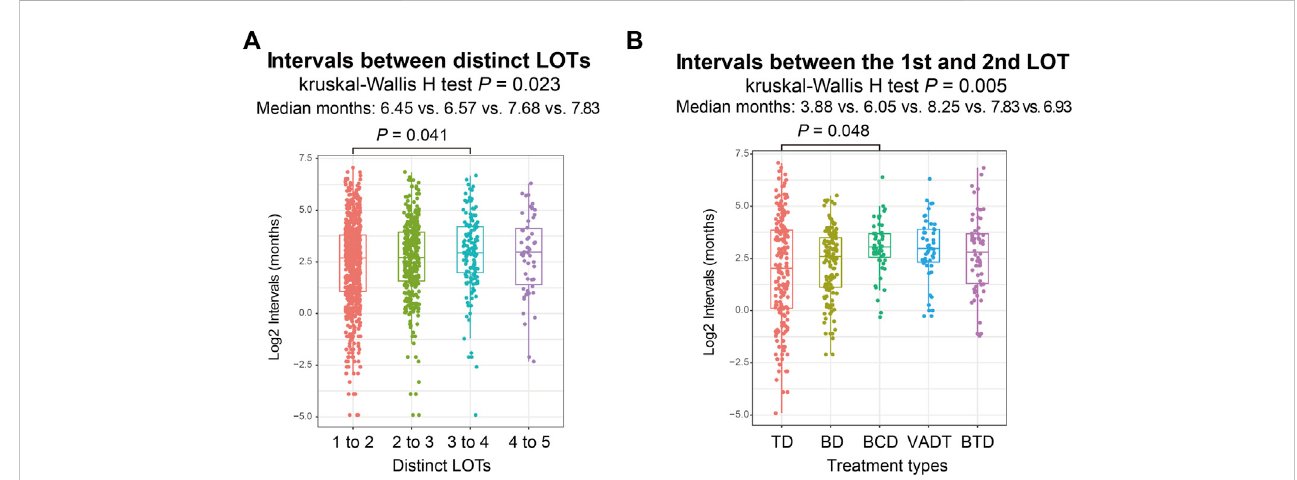
FIGURE 2 (A) Intervals betweendistinct LOTs intotalMM patients. (B) Intervals fromthe fi rst LOTto thesecond LOTamong differentfrontline treatmentregimens.